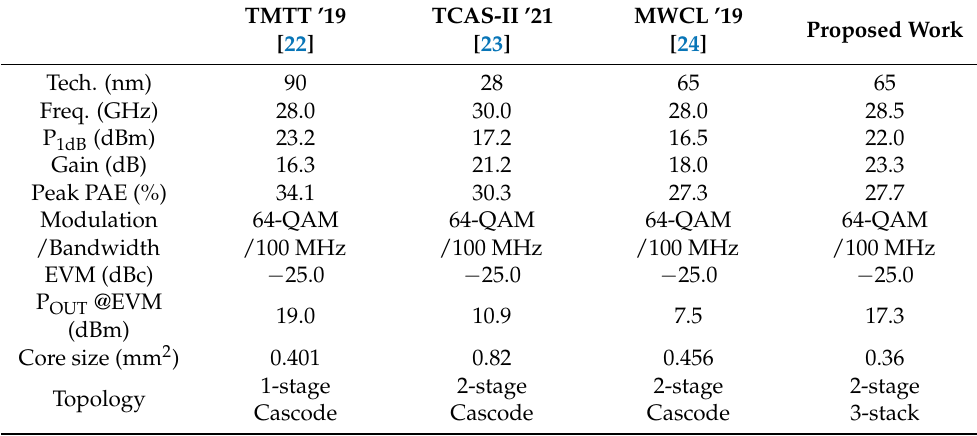
Figure 17. Measurement results: P MAX and ACLR according to the frequency with modulation signal (64-QAM, 100 MHz bandwidth, 9.7 dB PAPR). Table 1. Comparison with state-of-the-art of CMOS